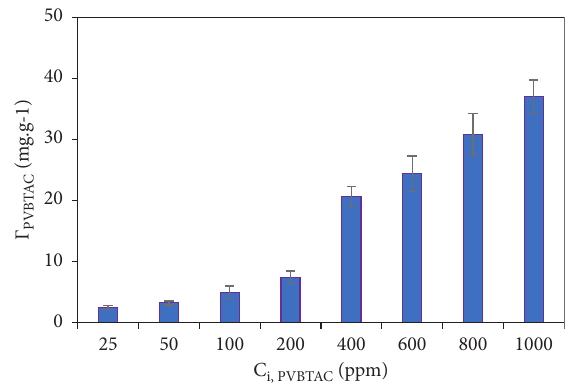
Figure 4: Initial concentration effect on the PVBTAC adsorption on the α -Al 2 O 3 particles at pH 8, NaCl 100mM, t of 2h and m α -Al2O3 of 5 mg mL − 1